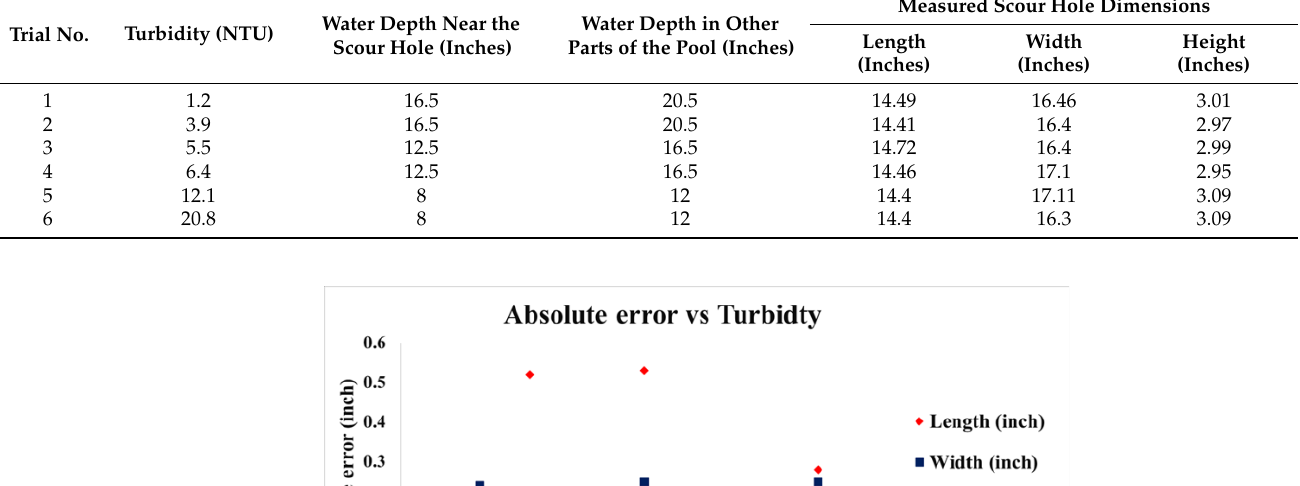
Table 1. Summary of results from the experiment [35,36] (used with permission). Trial No.